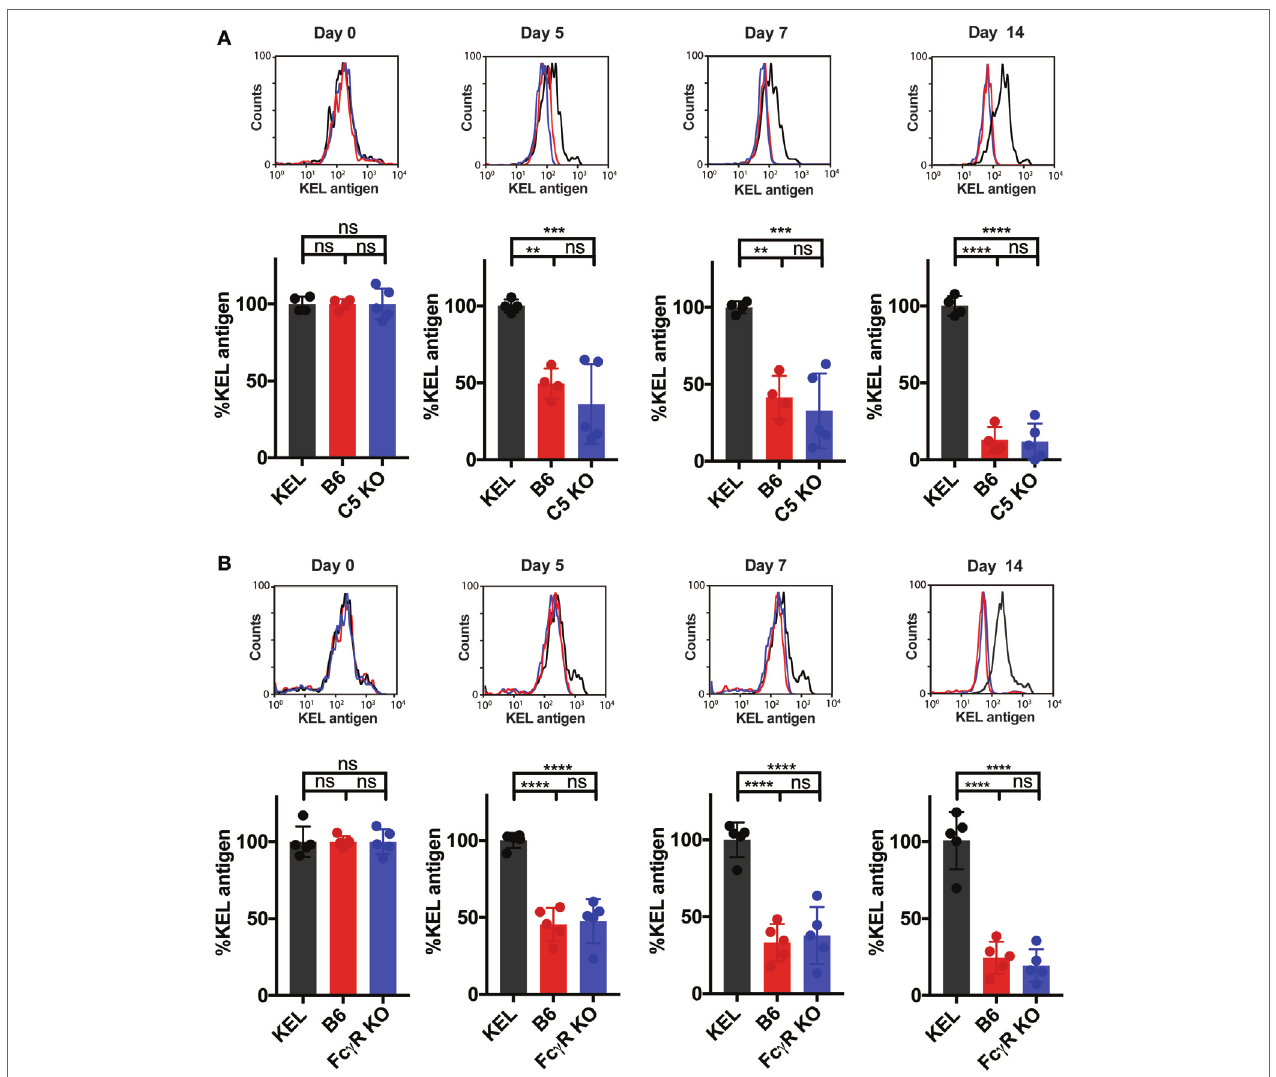
FigUre 7 | C5 and activating Fc γ gamma receptors (Fc γ Rs) do not impact KEL antigen levels on transfused KEL red blood cells (RBCs) over time. (a,B) B6, C5 KO, and Fc γ R KO mice were transfused with DiI-labeled KEL + RBCs and DiO-labeled KEL − RBCs. As a control, KEL mice were transfused with syngeneic DiI-labeled KEL + RBCs and DiO-labeled KEL − RBCs. Post-transfusion, DiI-labeled KEL + RBCs were stained for level of detectable KEL antigen using an anti-KEL polyclonal antibody. The level of detectable KEL antigen was measured as a percentage of KEL antigen normalized to the level of detectable KEL antigen in KEL mice transfused with syngeneic DiI-KEL + RBCs, shown at days 0, 5, 7, and 14 post-transfusion for either C5 KO (a) or Fc γ R KO (B) mice. (a,B) **** p < 0.0001, *** p < 0.0007, ** p < 0.006 and ns = not significant. Means ± SD